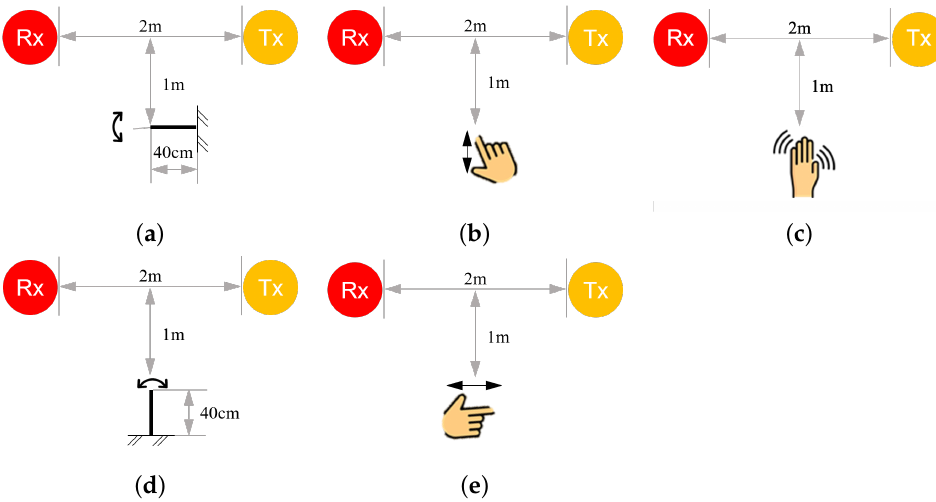
Figure 4. Experimental deployment of the three types of motion, including steel ruler vibration, finger tapping, and hand resting tremor. ( a ) The steel ruler vibration perpendicular to LoS. ( b ) The finger tapping perpendicular to LoS. ( c ) Hand resting tremor. ( d ) The steel ruler vibration parallel to LoS. ( e ) The finger tapping parallel to